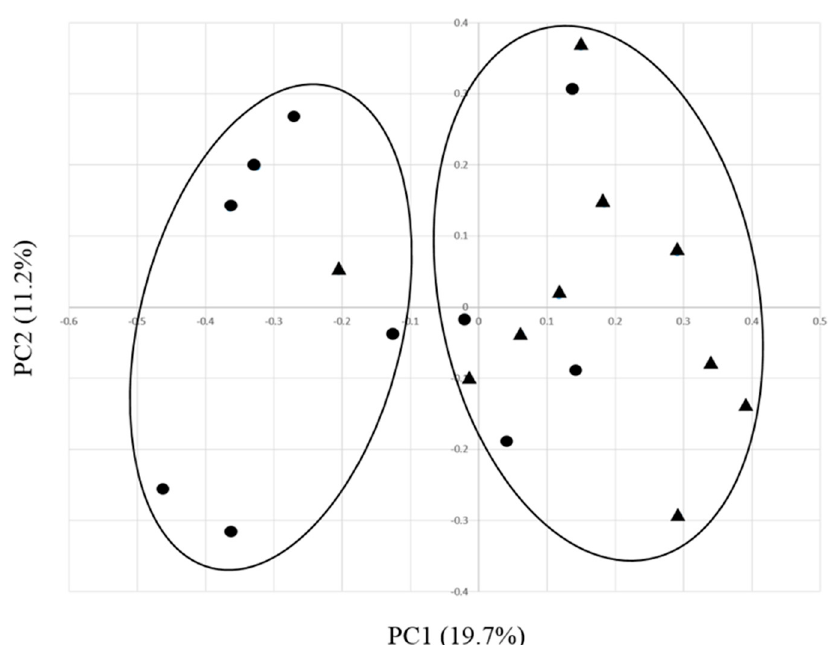
Figure 3. Comparison of rumen bacterial communities from EO-supplemented and control diet fed dairy calves using principle coordinate analysis (PCoA). The x and y axes correspond to Principal Components 1 (PC1) and 2 (PC2), which explained the highest level of variation. EO and control samples are represented by circles and triangles, respectively.